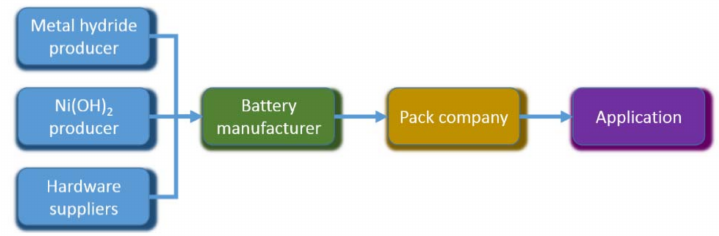
Figure 1. Schematic diagram showing the supply chain for the nickel/metal hydride (Ni/MH) battery industry.